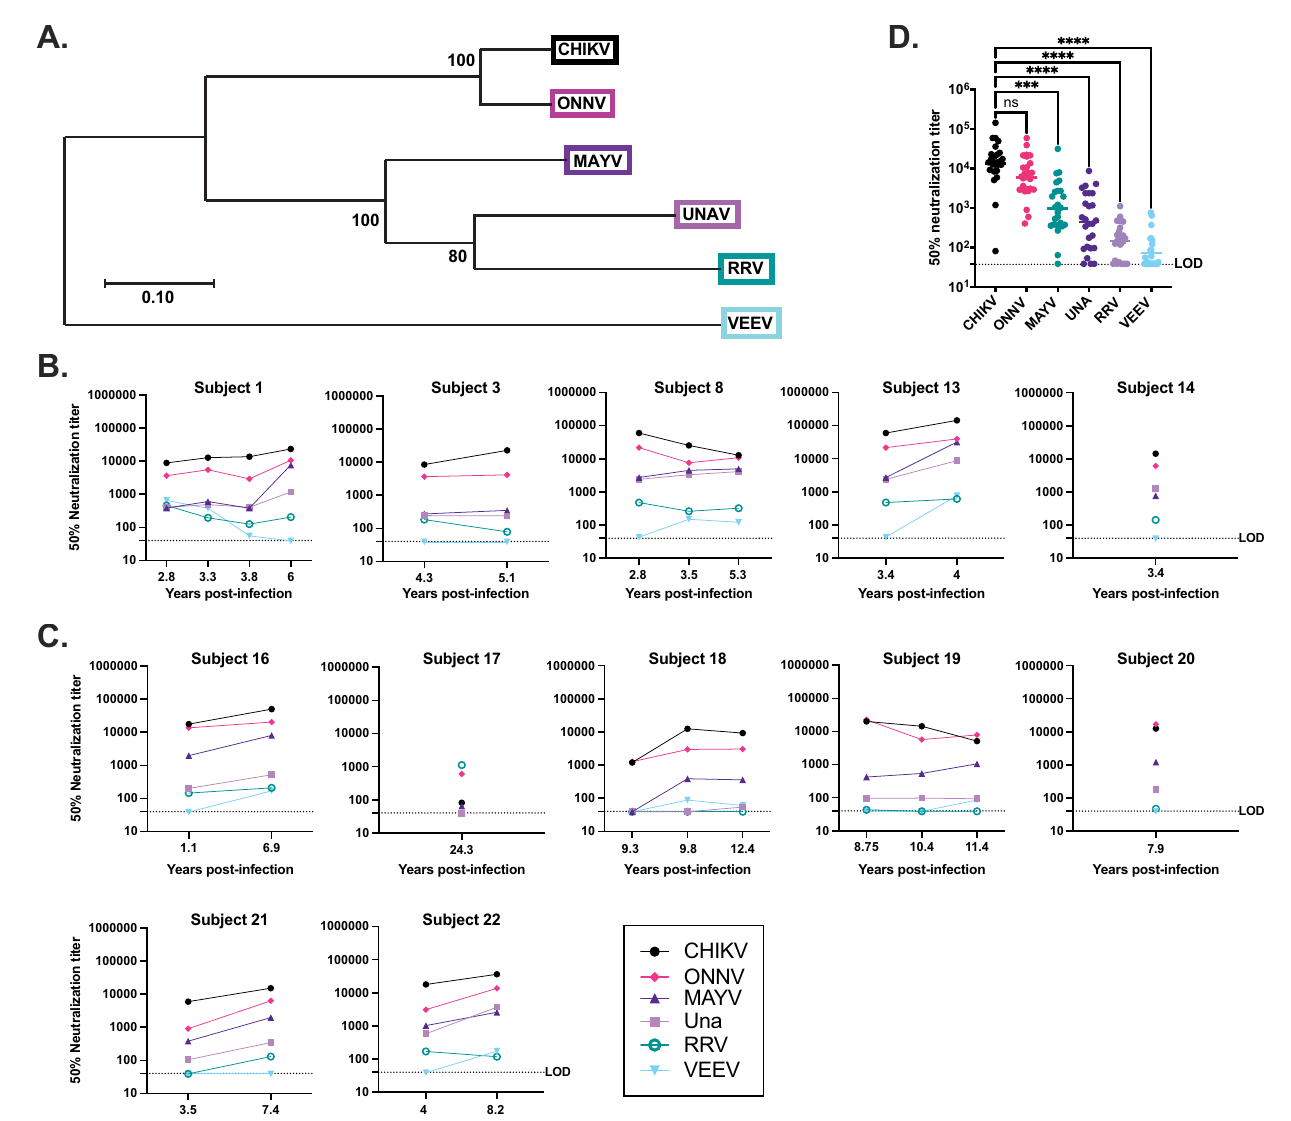
Fig 1. Longitudinal serology for endemic and non-endemic patients. (A) Phylogenetic tree produced using the E1, 6k, and E2 amino acid sequences for the six alphaviruses under investigation; viruses are color coded to match serology graphs. (B, C) Sera samples from each subject were tested for neutralization activity against CHIKV, ONNV, RRV, MAYV, Una, and VEEV by plaque reduction neutralization titer assays (PRNT) performed on confluent monolayers of Vero cells. Shown are the average 50% reduction titer values (PRNT 50 ) calculated by variable slope non-linear regression using Prism software. Longitudinal serology is shown for 9/12 human subjects. Additional samples for the other human subjects were unavailable. Endemic subject serologic profiles are shown in (B). Serology for non-endemic subjects is shown in (C). (D) Summarizes the breadth of cross-neutralization data for both endemic and non-endemic subjects at all time points presented in (B) and (C). The statistical analysis to compare grouped cross-neutralizing PRNT 50 values to CHIKV